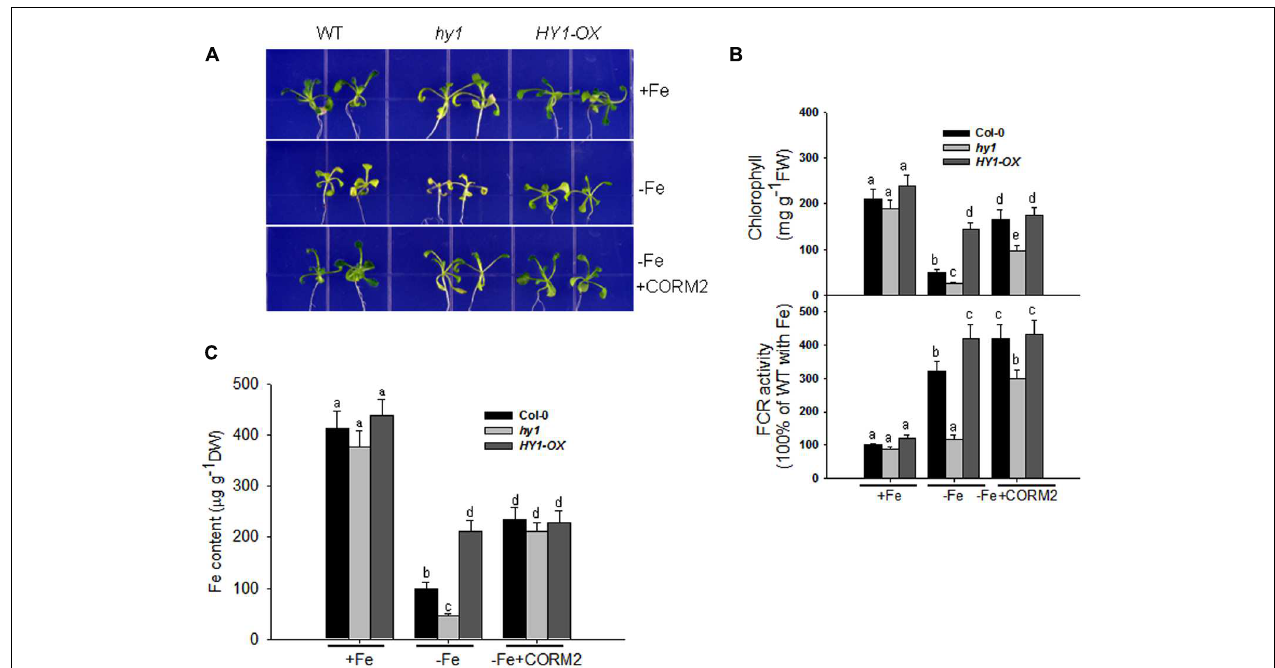
FIGURE 2 | The differential responses of the hy1 mutant and HY1-OX line to Fe deficiency. (A) The phenotype of wild-type Col-0, hy1 , and HY1-OX lines in response to –Fe stress. Upper: + Fe media; Middle panel: –Fe media; Bottom: –Fe media plus the CO donor, CORM2. Col-0, hy1, and HY1-OX seeds were germinated for 7 days and then grown on vermiculite with fresh complete nutrient solution for another 7 days. The seeds were transferred to –Fe hydroponic media or –Fe hydroponic media plus 100 nM CORM2 for 1 week and then photographed. Seedlings growing in the + Fe hydroponic media were used as the positive control. (B,C) Quantification of chlorophyll content (B) , FCR activity (B) , and Fe content (C) of plants growing in + Fe or –Fe hydroponic media. Two-week-old seedlings of the Col-0, hy1, and HY1-OX lines were grown in + Fe hydroponic media, were shifted to –Fe hydroponic media for 1 week, and the chlorophyll content and FCR activity were measured. Seedlings left in + Fe hydroponic media were used as the control. Data are the means ± SD ( n = 12), and bars labeled with different letters are significantly different at p < 0.05 (Tukey’s